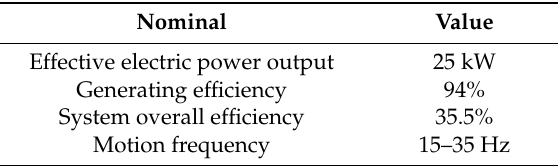
Table 1. Crucial design specifications.